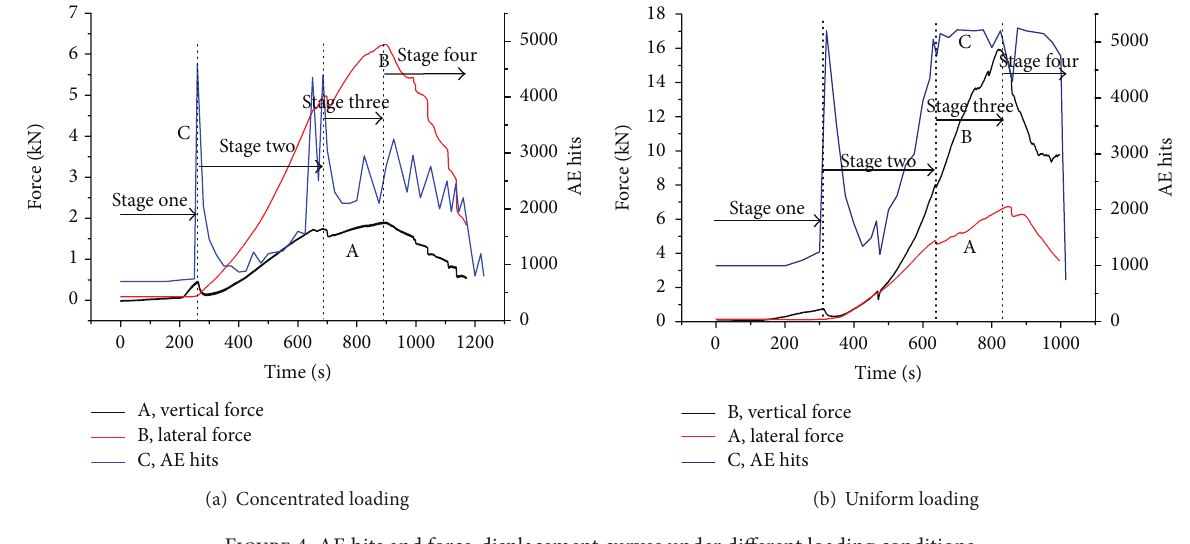
Figure 4: AE hits and force-displacement curves under different loading conditions.